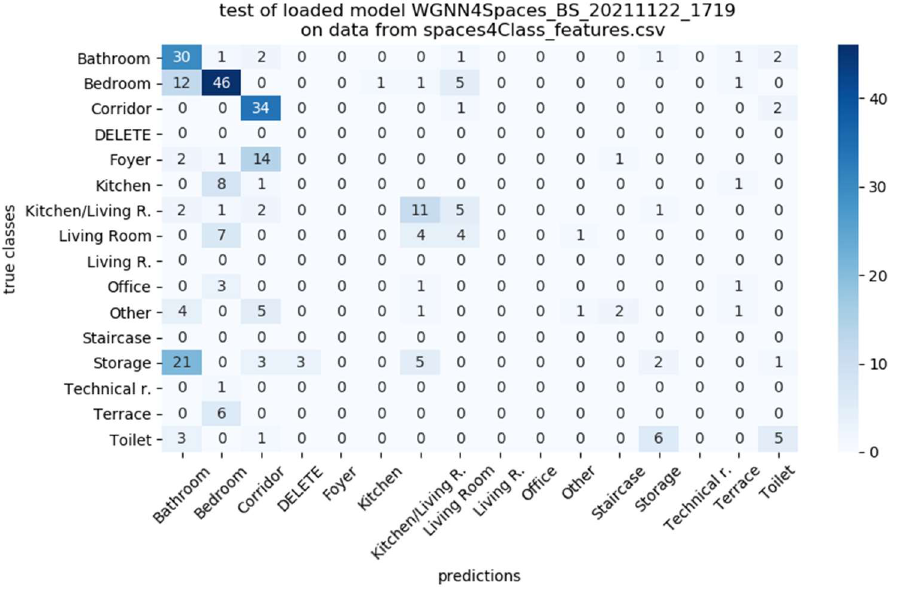
Figure 5. Confusion matrix for the inductive inference test of the WGCN model. The model was trained on a proprietary set of IFC files with 1500 spaces and validated on 283 other spaces from other IFC models as a realistic inference test.